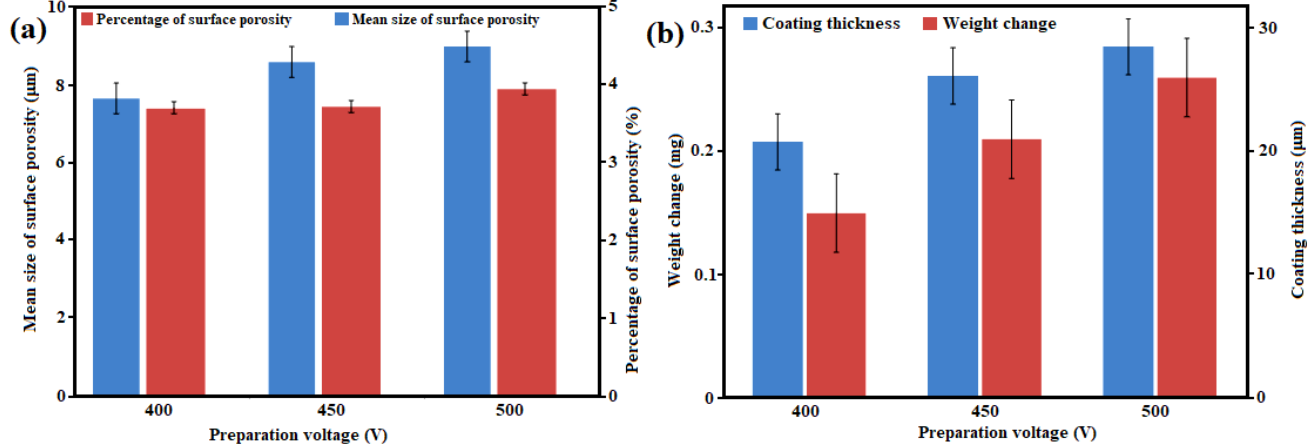
Figure 4. ( a ) Size and percentage of surface pores and ( b ) variation of coating thickness and specimen's weight change for PEO coating samples prepared under applied voltages of 400 V, 450 V, and 500 V.